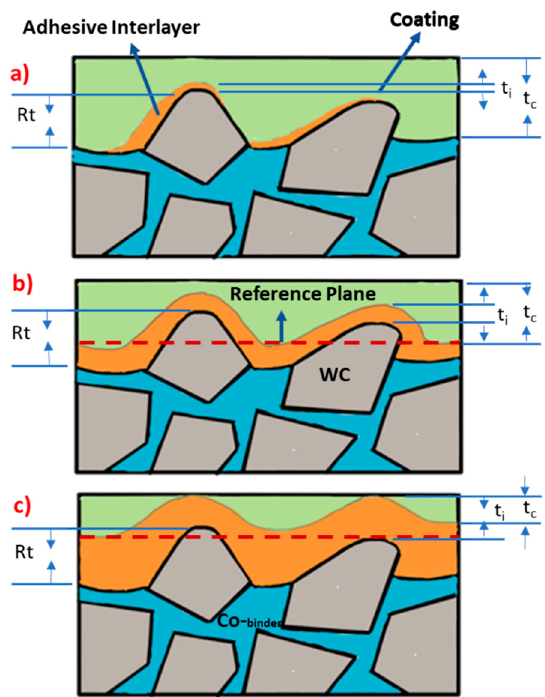
Figure 2. Schematic diagram of interlayer thickness effect on the coating substrate adhesion ( a ), and on the entire coating structure shear strength in a reference plane ( b , c ), with the same roughness of cemented carbide substrate [22] , t i and t c represent interlayer and coating thicknesses respectively.